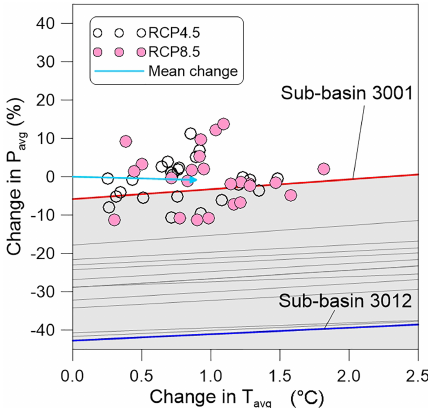
Figure 4. Climatic bounds for probability [ ρ s > 0 . 95 ] = 95% for the 14 sub-basins on which the 50 GCM projections for 2020–2039 were